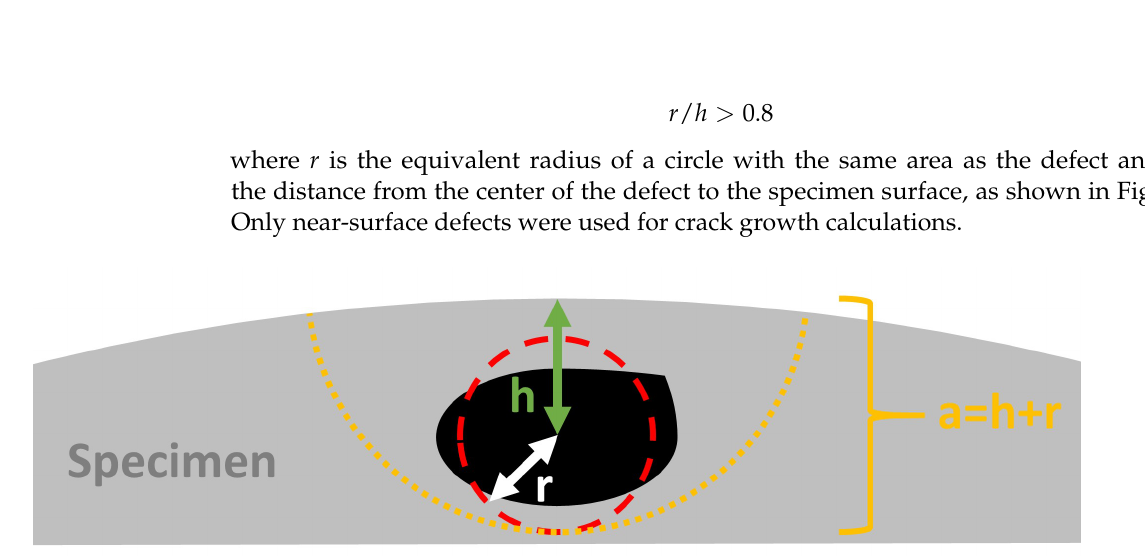
Figure 3. Definitions of the equivalent radius ( r ) and location ( h ) of a defect according to the Murakami criterion (1) [24]. The depth parameter a used for calculations was evaluated as a = h + r